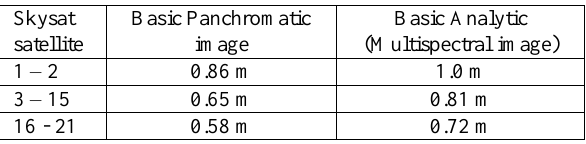
Table 2: GSD of the Planet supplied images in nadir view The GSD of the panchromatic images supplied by Planet (Planet Imagery Product Specification 2021) corresponds to a pixel size of 5.2 µm, i.e. the GSD is reduced by the factor 1.25 due to the super-resolution. The corresponding images have 3199 x 1349 pixels. Image sharpening is a common technique used also by other satellite image distributors. The GSD of the orthoimages as the SkySat Collect (Figure 3) is reduced to 0.50 m.